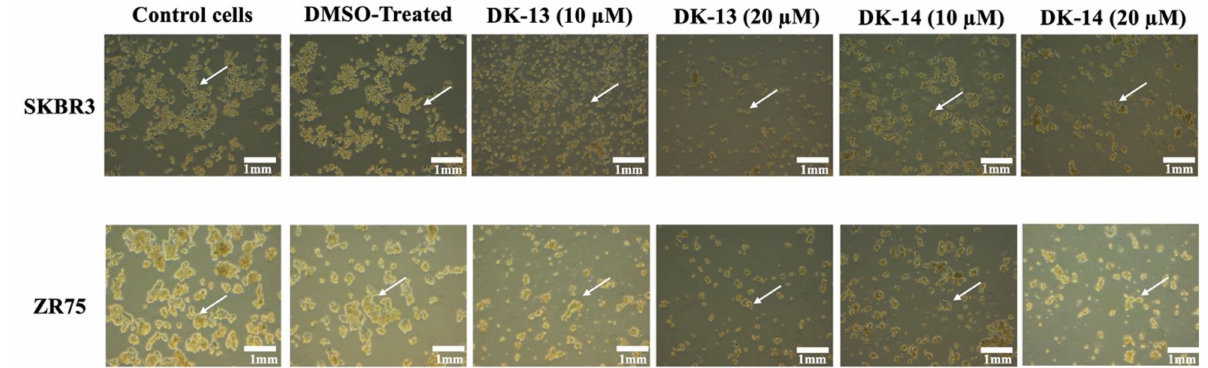
Figure 2. Effect of cell morphology on chalcone compounds DK-13 and 14 in the HER2-positive breast cancer cell lines, SKBR3 and ZR75. We observe that treatment for 48 h with 10 and 20 µ M of compounds DK-13 and 14 induces cell death and the formation of a monolayer of cells in both cell lines (white arrows indicate loss of cell-cell adhesion), in comparison with untreated (control) and DMSO-treated (negative control) cells, which show no cytotoxic effect, display a round phenotype and form multilayers; white arrows indicate epithelial morphology with clear cell-cell